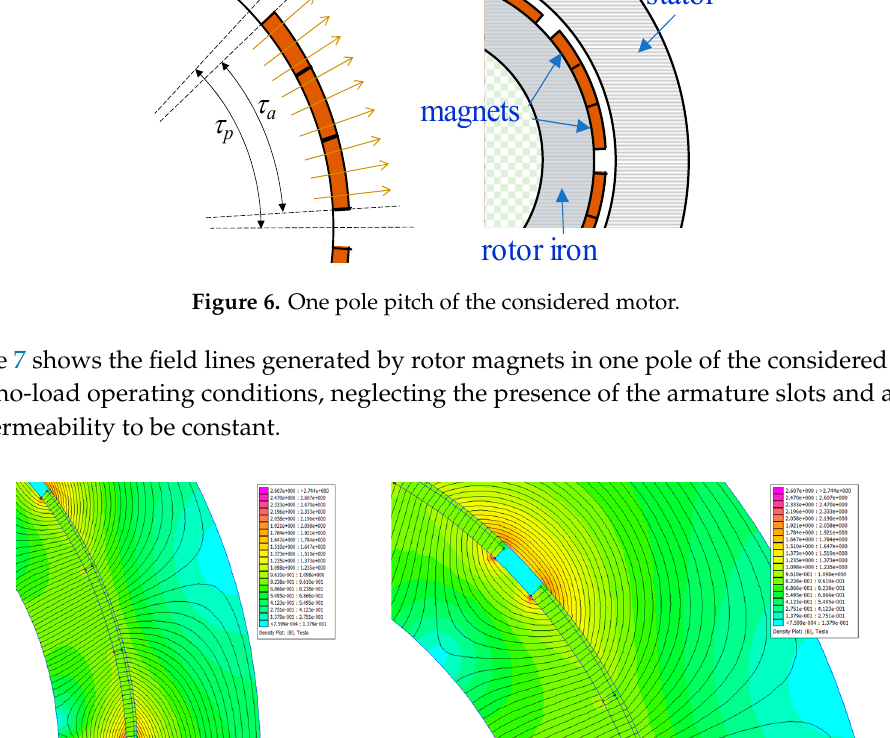
Figure 5. Sinusoidal magnetization of the magnets. Air gap flux ‐ density due to the rotor magnets for 1 = / 4 (blue line) ; 1 = /8 (red line).